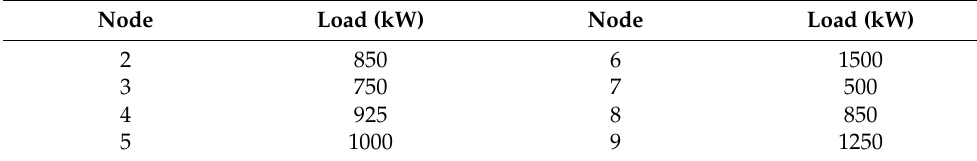
Table 3. Load consumption for a numerical example (lagging power factor of 0.9). Node Load (kW)